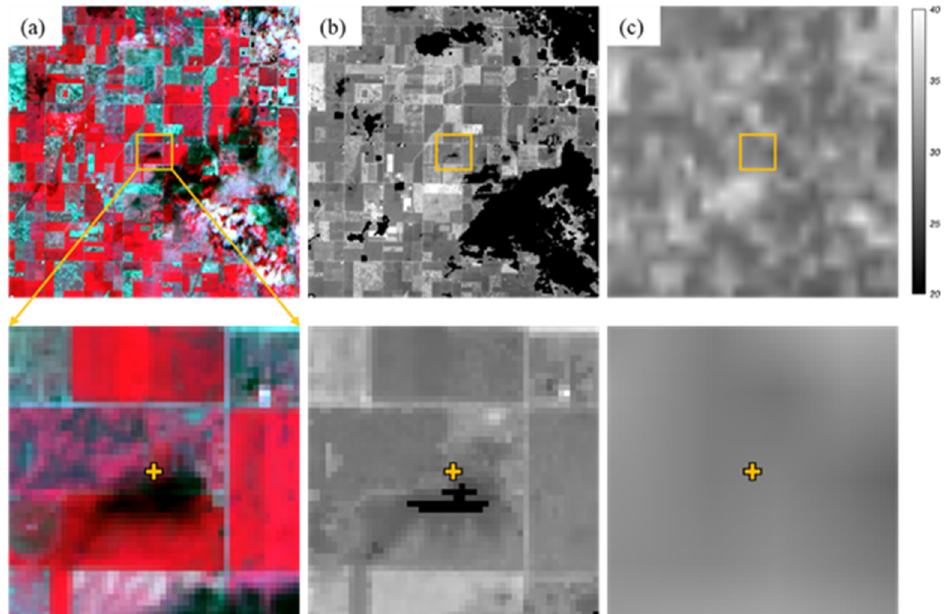
Figure 16. ( a ) The NIR-Red-Green composite (400 × 400) of S2 SR bands, ( b ) the sharpened VIIRS LST and ( c ) native VIIRS LST on DOY 166 centered on the USBo1 site over Bondville domain. The zoom-in view (50 × 50) of ( a – c ) is shown in the bottom row. Yellow cross represents the location of flux tower.